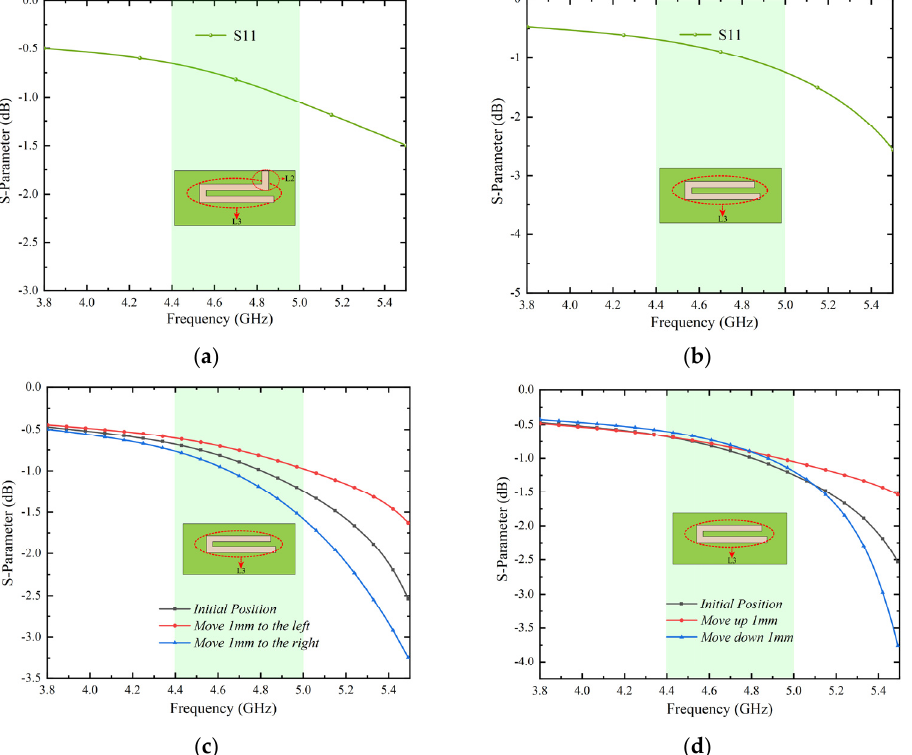
Figure 5. Simulation results. ( a ): Reflection coefficients without L1, ( b ): reflection coefficients without L1 and L2, ( c ): the reflection coefficients obtained after moving the feeding line to the left and right, respectively, and ( d ): the reflection coefficient obtained after moving the feeding line up and down, respectively.